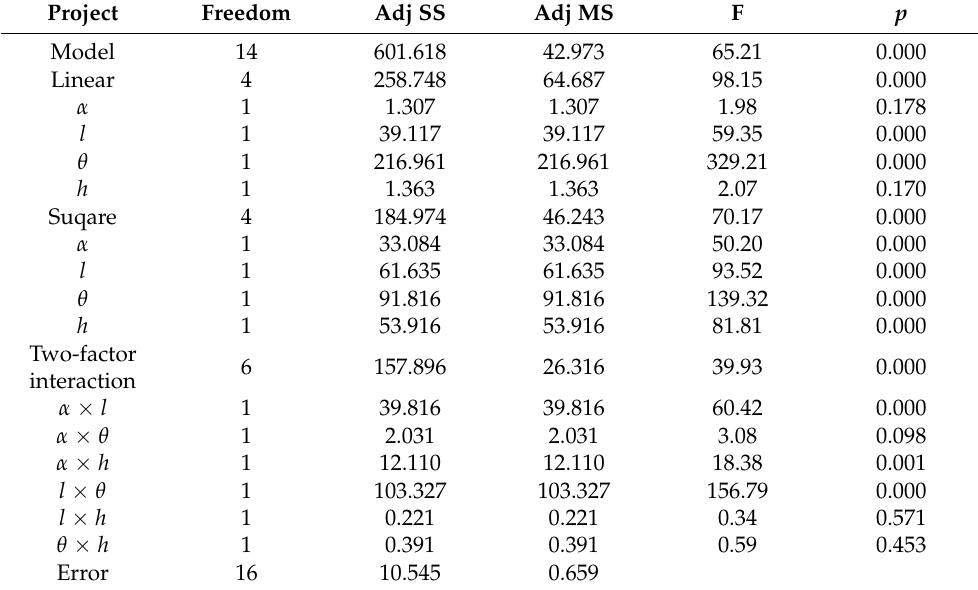
Table 2. ANOVA of uniformity coefficient.